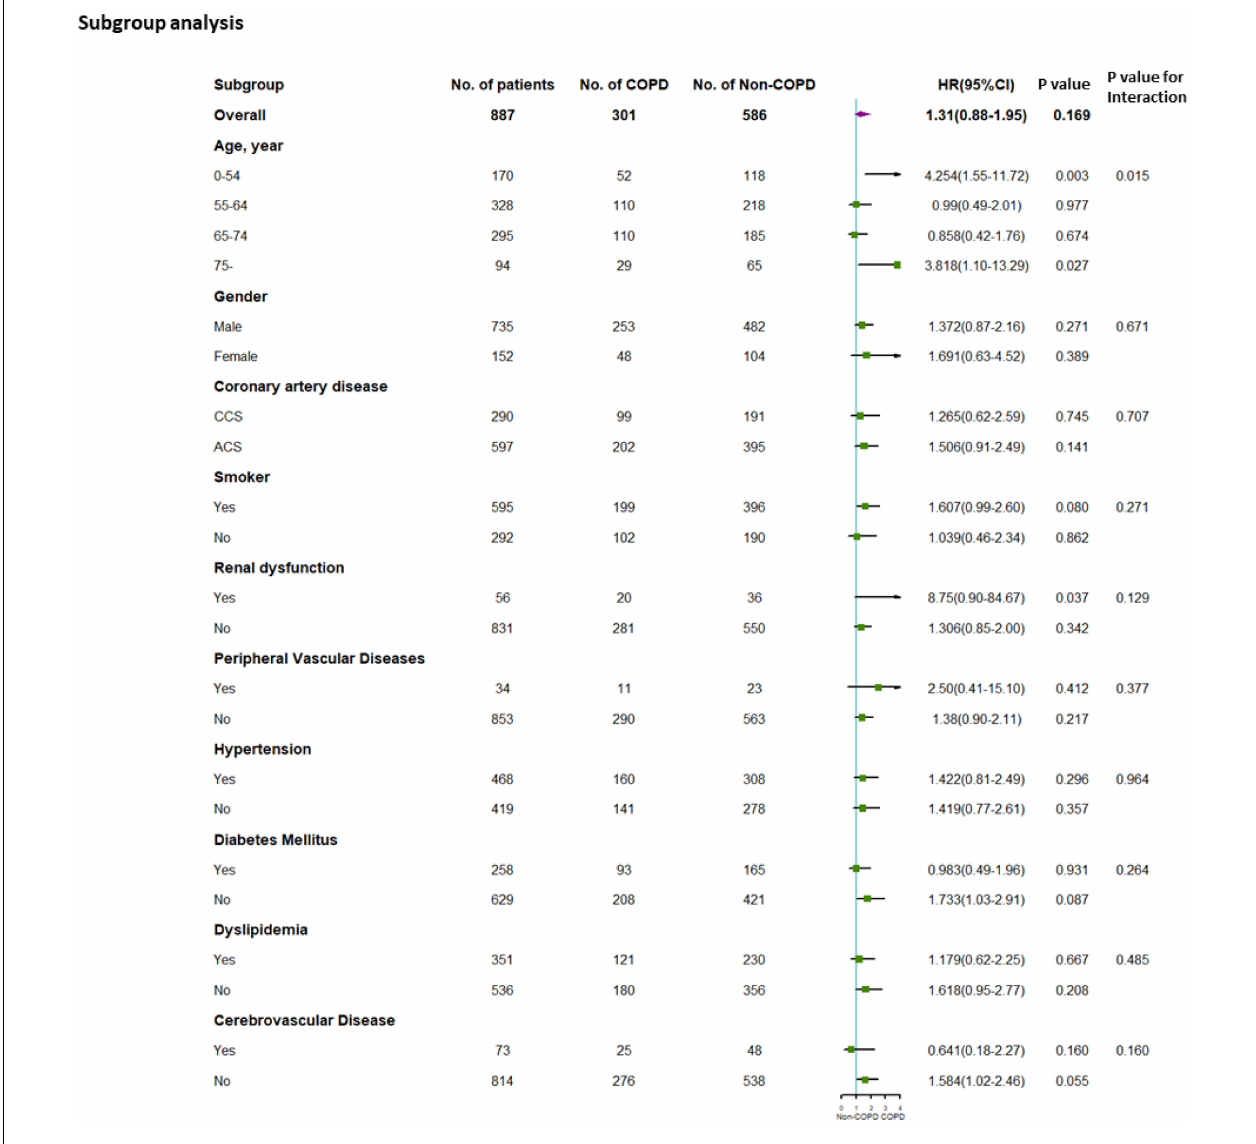
FIGURE 4 | Subgroup analysis for the PFT cohort. Subgroup analysis performed according to possible covariates. CCS, chronic coronary syndrome; ACS, acute coronary syndrome. HR, hazard